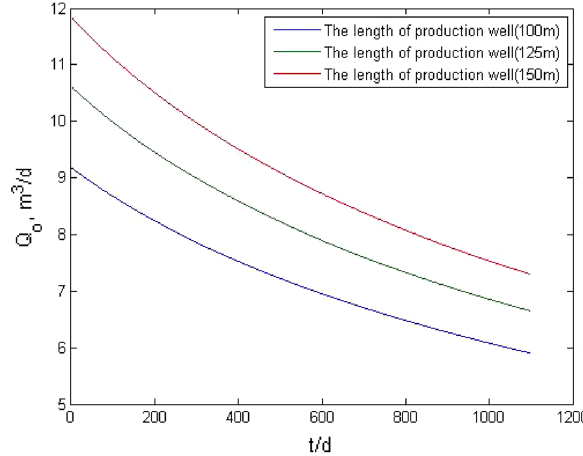
Fig. 9 Effects of fracture length of production well on production